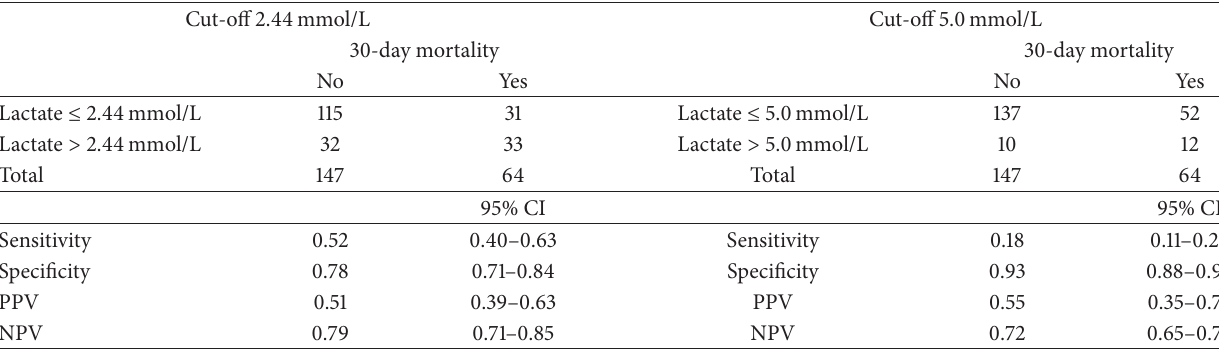
Table 4: Prediction of 30-day mortality with lactate cut off 2.44 and 5.0mmol/L.